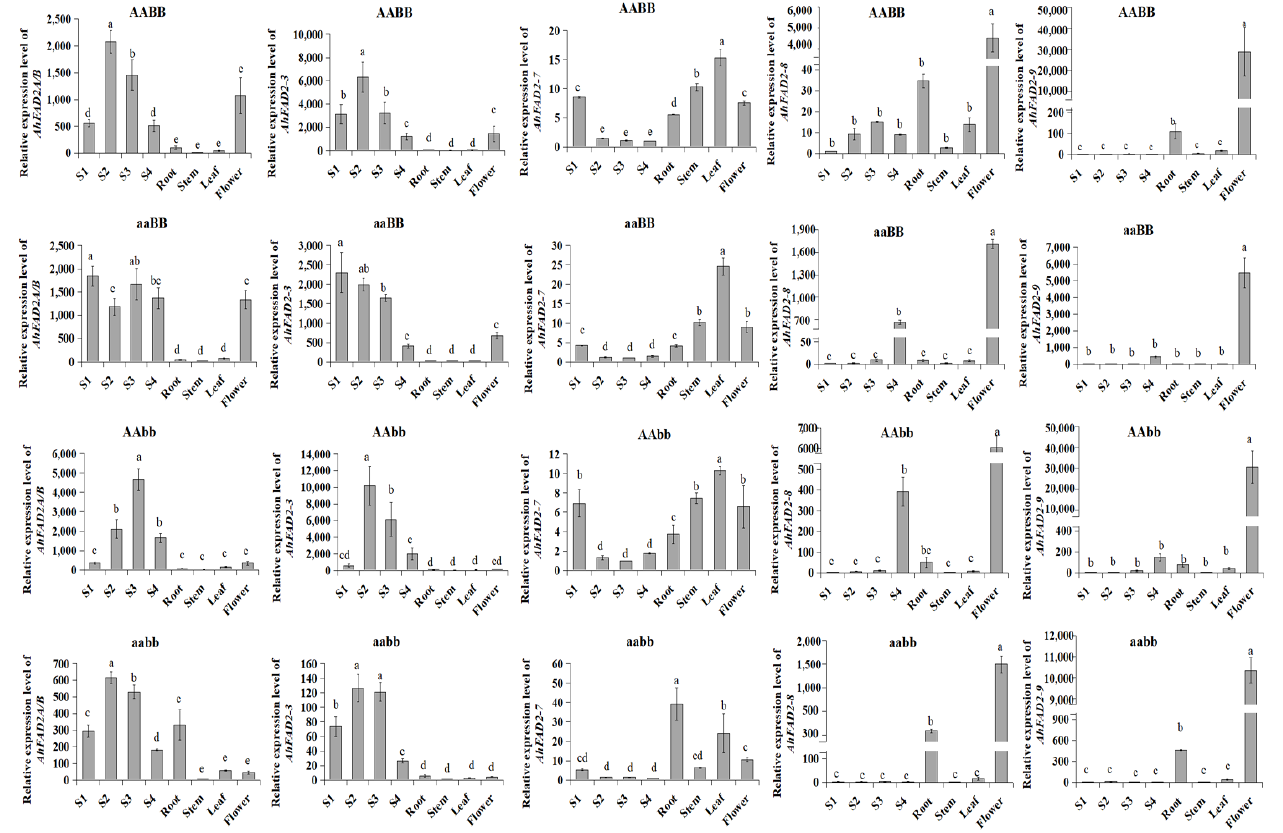
Figure 6. Expression analysis of five desaturase genes in different tissues of four genotypes using qRT-PCR. The bars are standard deviations (SDs) of three technical repeats. Different letters within a column indicate a significant difference at p < 0.05.